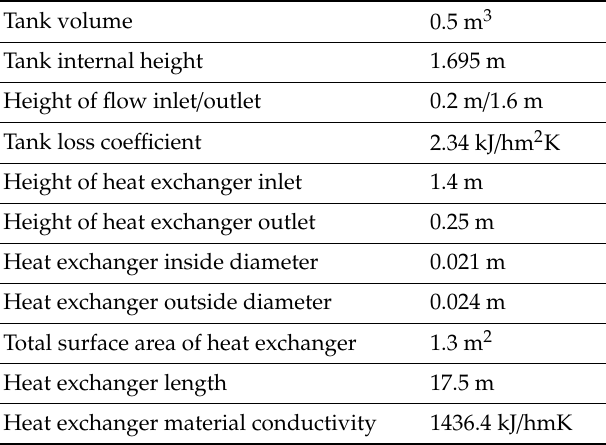
Table 4. The main characteristics of the thermal energy